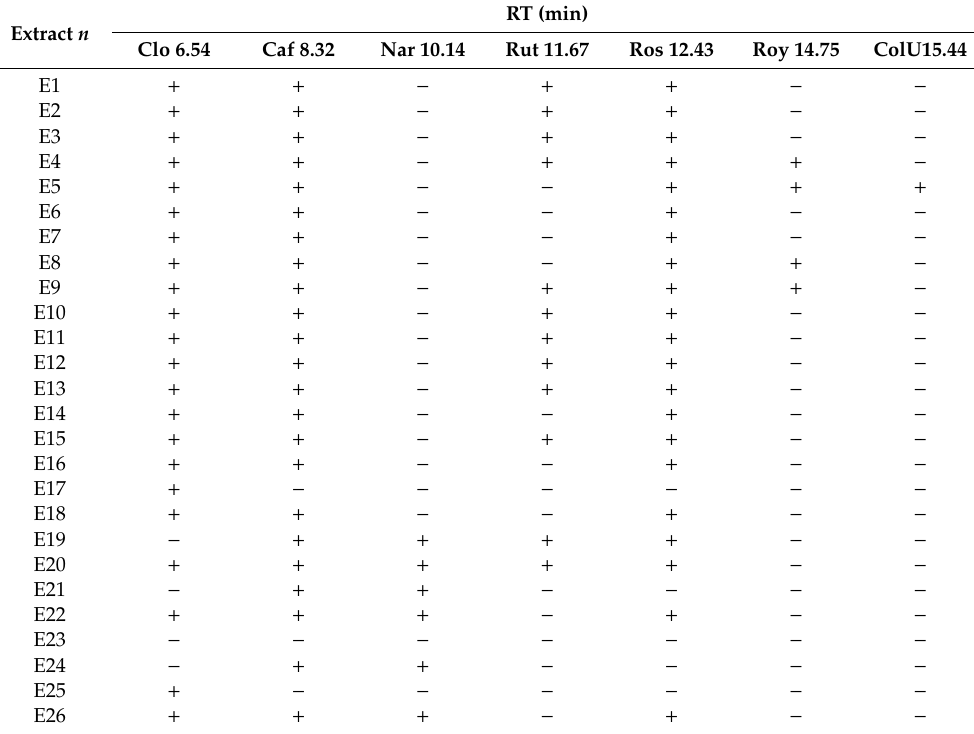
Table 4. Compounds detection in each Plectranthus spp. extract and their corresponding characteristic retention